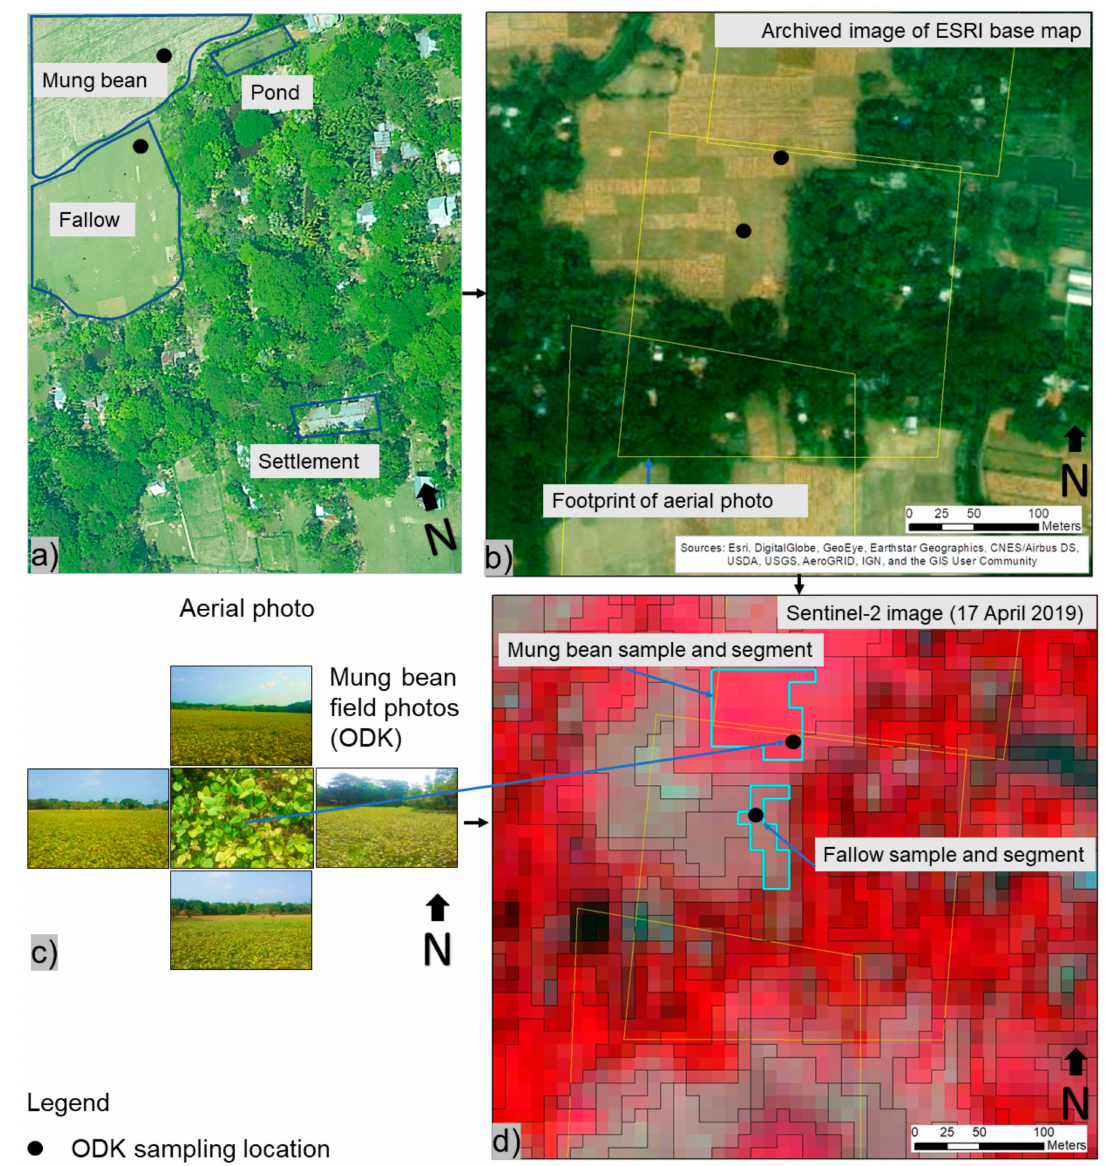
Figure 5. Training sample preparation workflow: We started with an aerial image ( a ), which we then related to the Google Earth background imagery ( b ). Subsequently, a field technician identified the crops shown on the aerial image in the field with the Open Data Kit (ODK); ( c ). In a last step, we linked the ODK data points with crop type information to segments based on Sentinel-2 images ( d